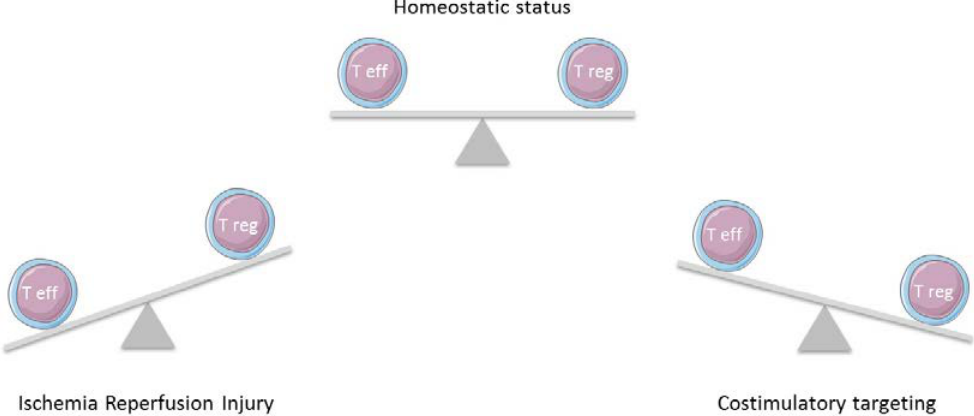
Figure 2. T effector cells have a major role in the inflammatory immune response after ischemic damage. Through modulating the costimulatory pathways, T regulatory cells will exert a strong influence to return